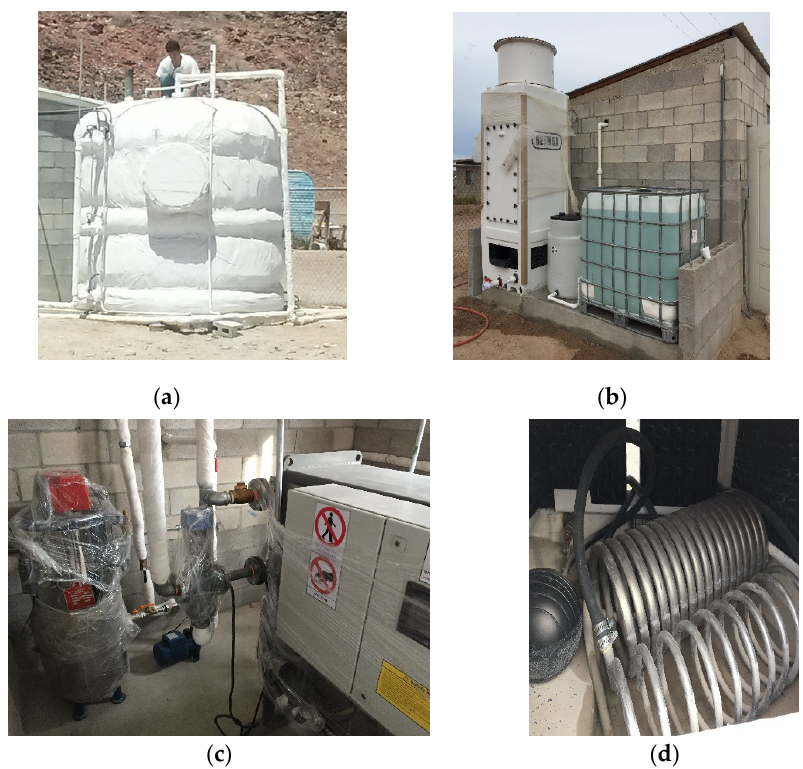
Figure 2. Components of the thermosolar absorption cooling system at Puertecitos school, where we can appreciate the ( a ) thermal energy storage tank, ( b ) cooling tower with freshwater and seawater storage tanks, ( c ) auxiliary heater and chiller inside the machine room, and ( d ) titanium coil inside the cooling tower.